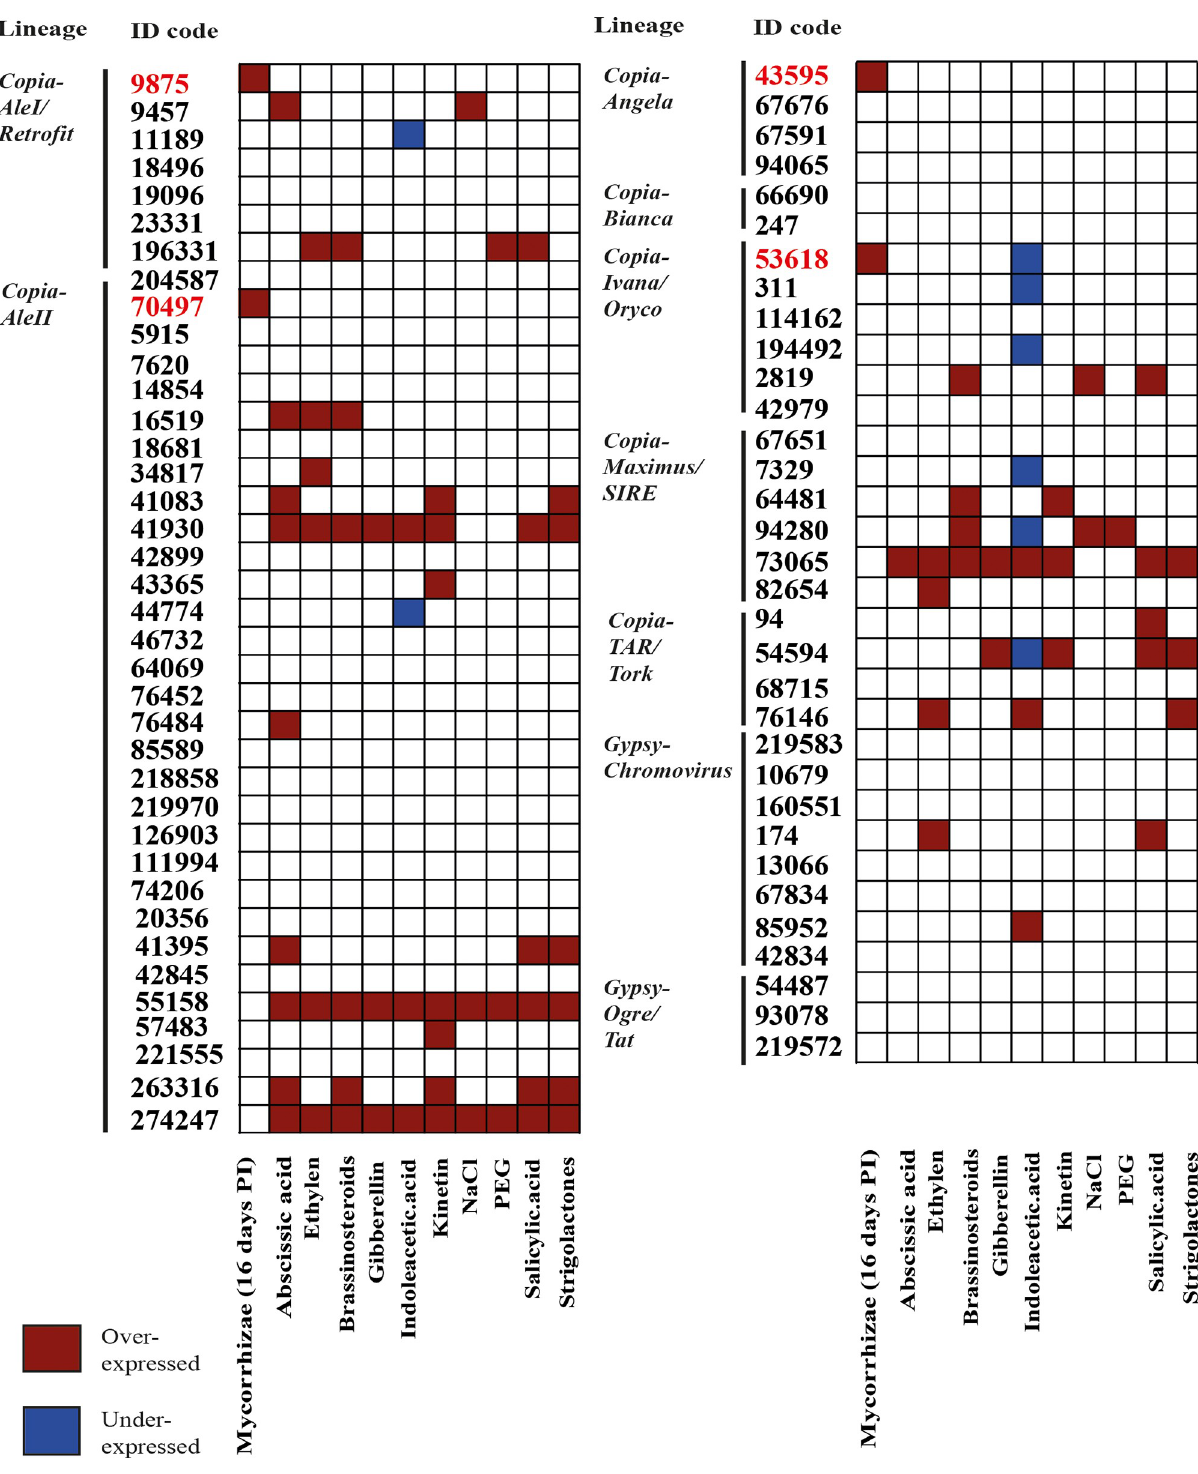
Fig 6. Differential expression of reverse transcriptase (RT)-encoding sequences after different treatments of Helianthus annuus plants. Analysis was performed only on expressed sequences. Libraries from cDNA of mycorrhizal roots and their controls were prepared during this study; the other libraries [45] were collected from the public database (see the materials and methods